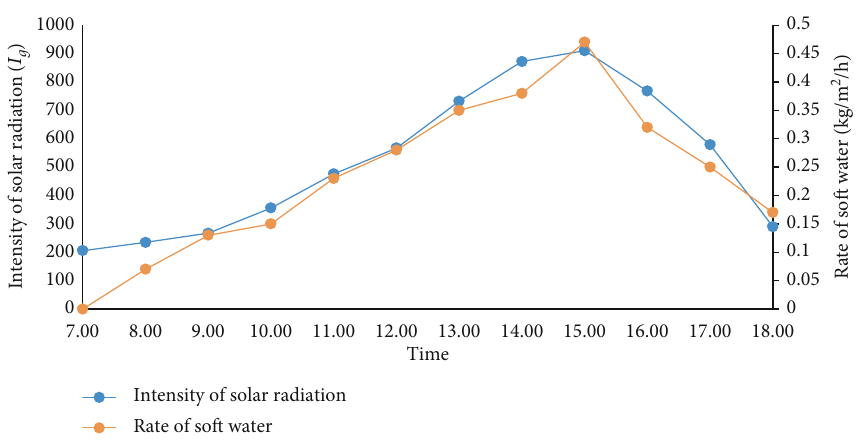
Figure 6: Rate of soft water generation and solar intensity versus time (re fl ective white paint on CPC).